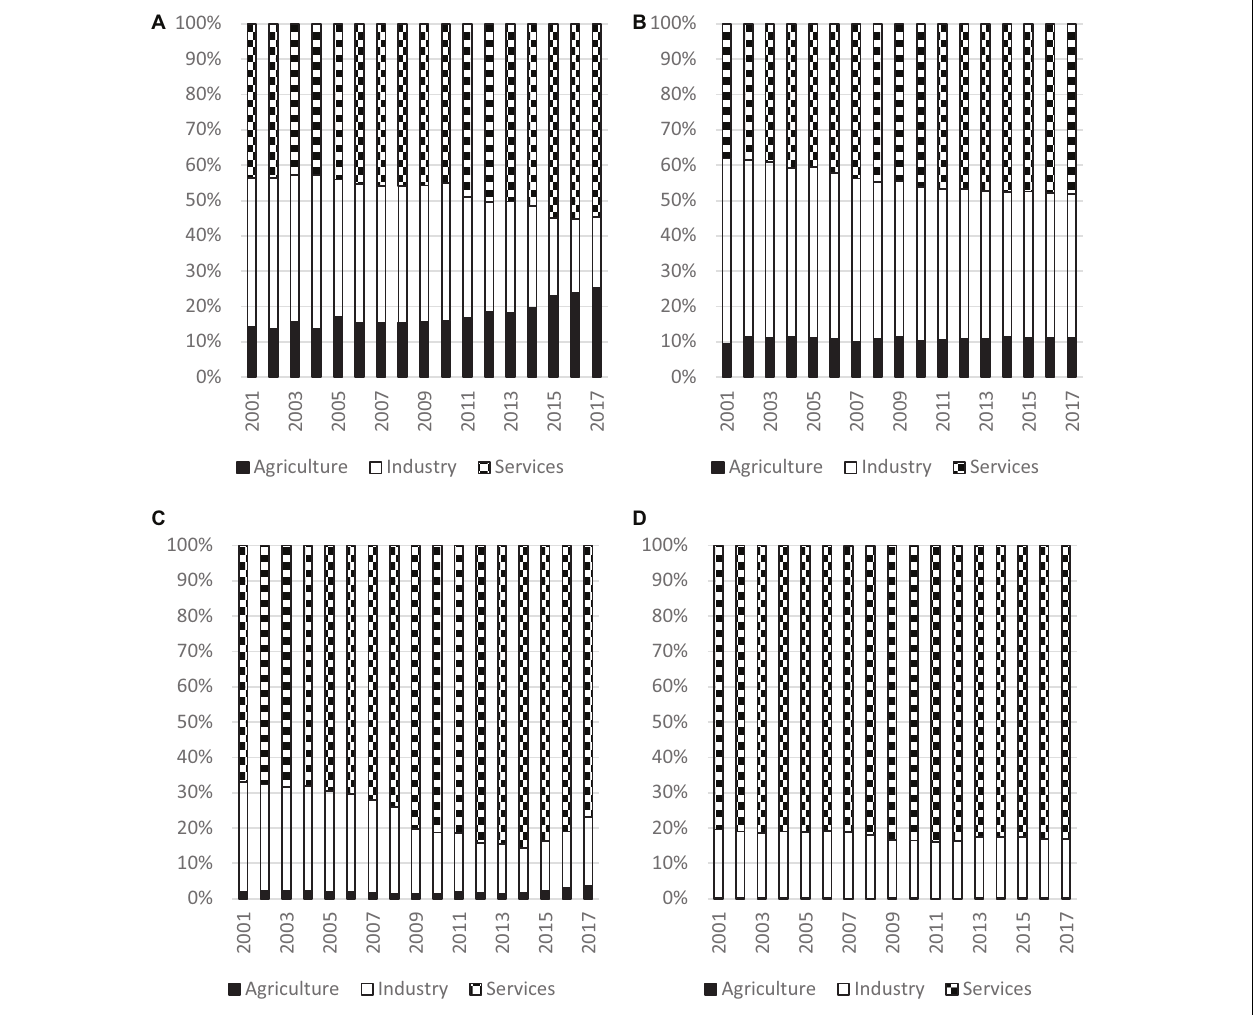
FIGURE 6 | Decomposition of Inequality for Different Income Groups, 2001 to 2017. Source: Authors’ calculation. (A) Low, (B) Lower-Middle, (C) Upper-Middle, and (D)